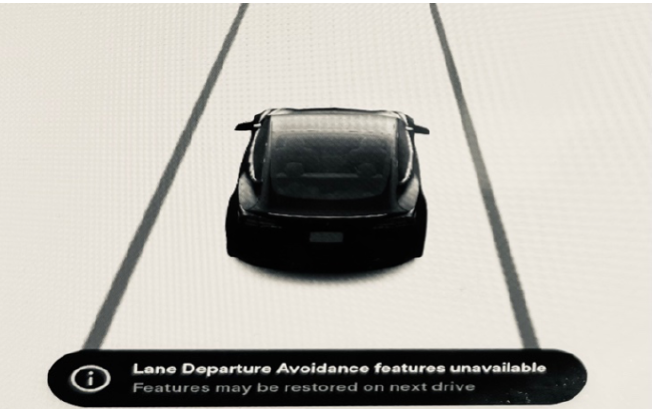
Figure 3. Disable warning output on a touchscreen by Tesla’s computer after a random number of correction